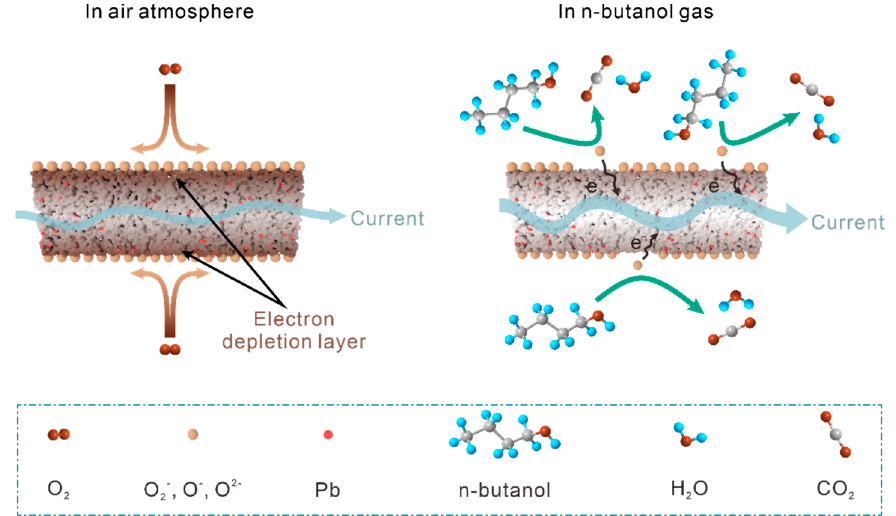
Figure 8. Possible sensing mechanism of porous Pb-doped ZnO nanobelts toward